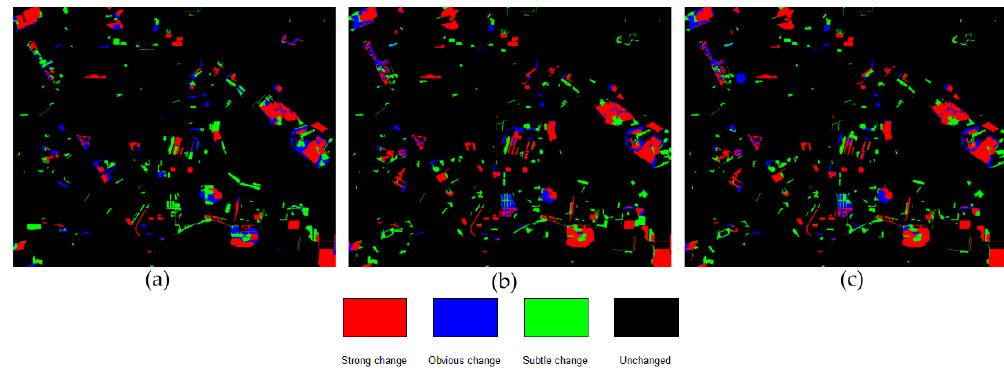
Figure 14. CD results based on majority voting. ( a ) ELM-MV; ( b ) RF-MV; ( c ) RoF-MV.